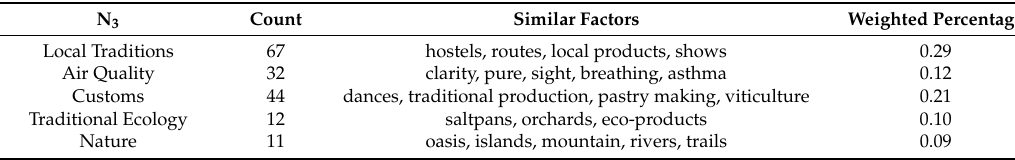
Table 12. Results for N 3 for environment factors identification.